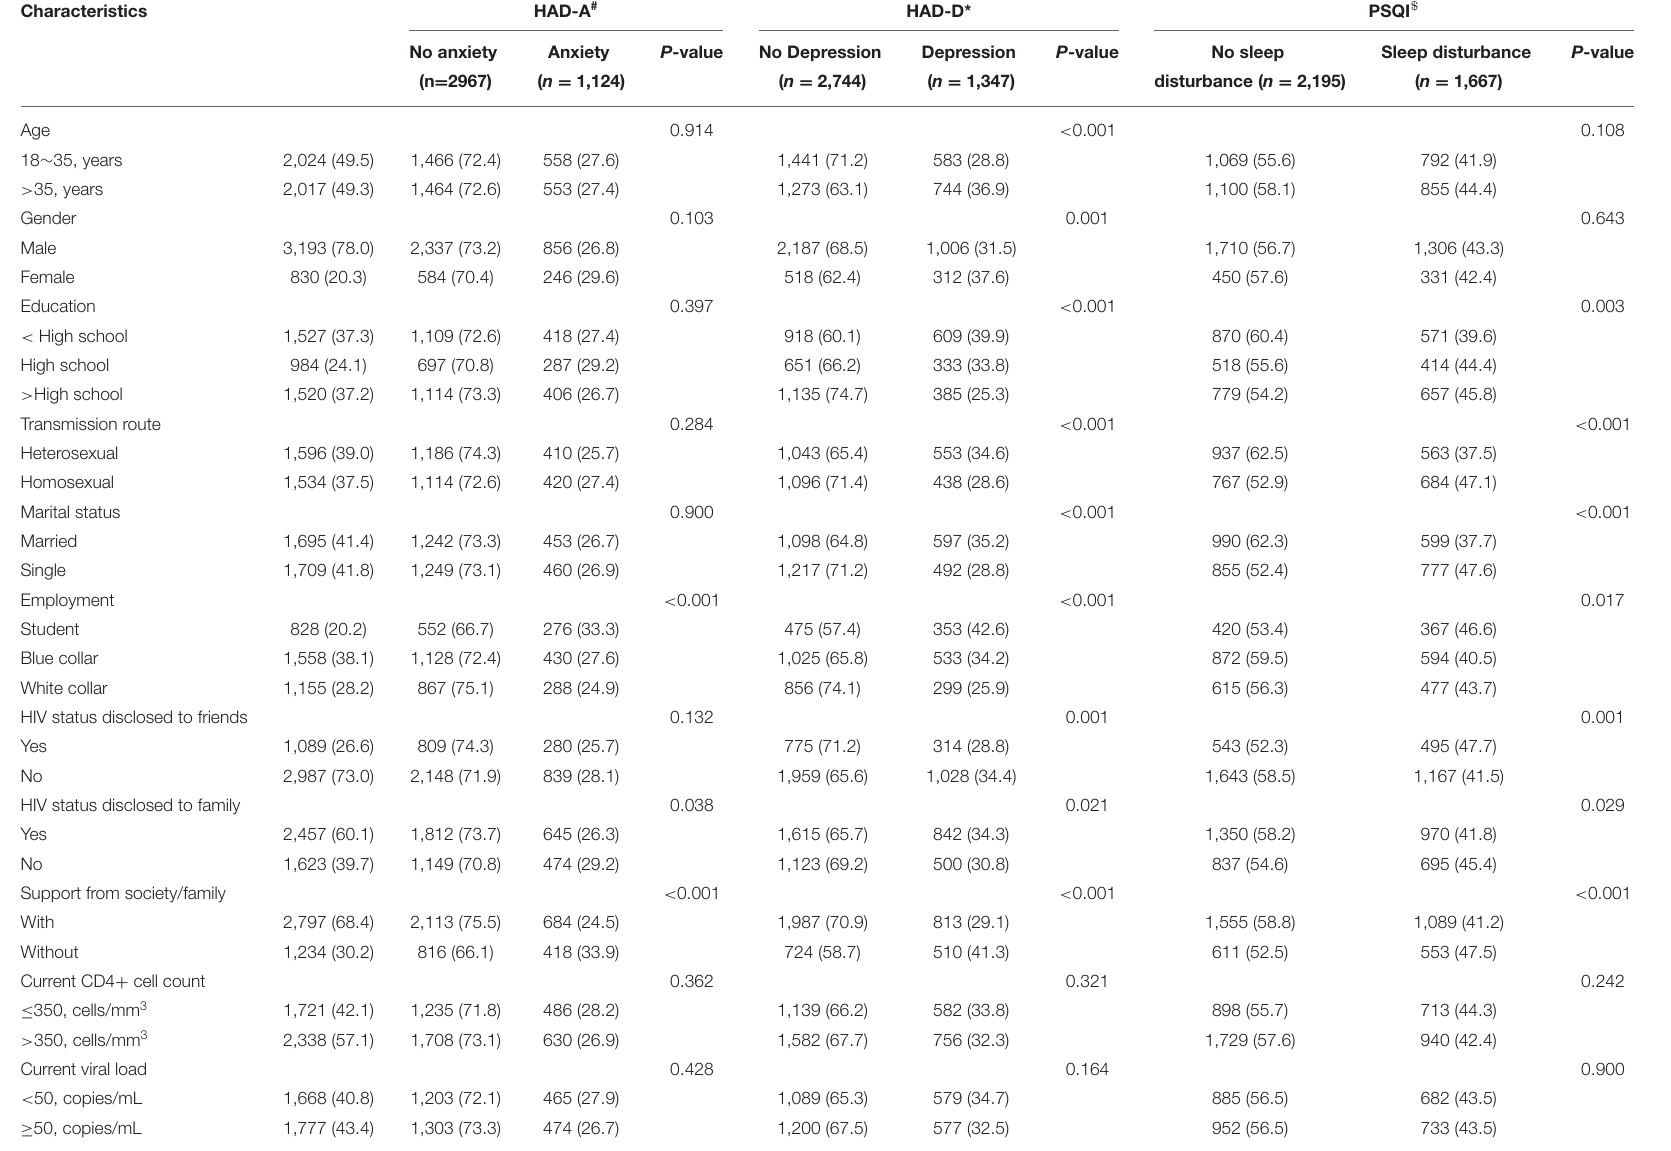
TABLE 2 | Characteristics of 4,091 HIV-infected persons ( n